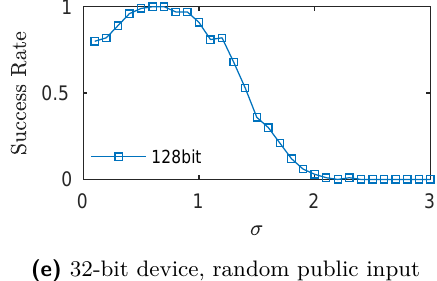
Figure 4: Success rate on simulated traces as function of noise level σ , for various scenarios (random public input state and all-zero public input), word sizes (8, 16, 32-bit devices), and key lengths (128 and 256 bit). Settings that did not yield any successful experiments are not